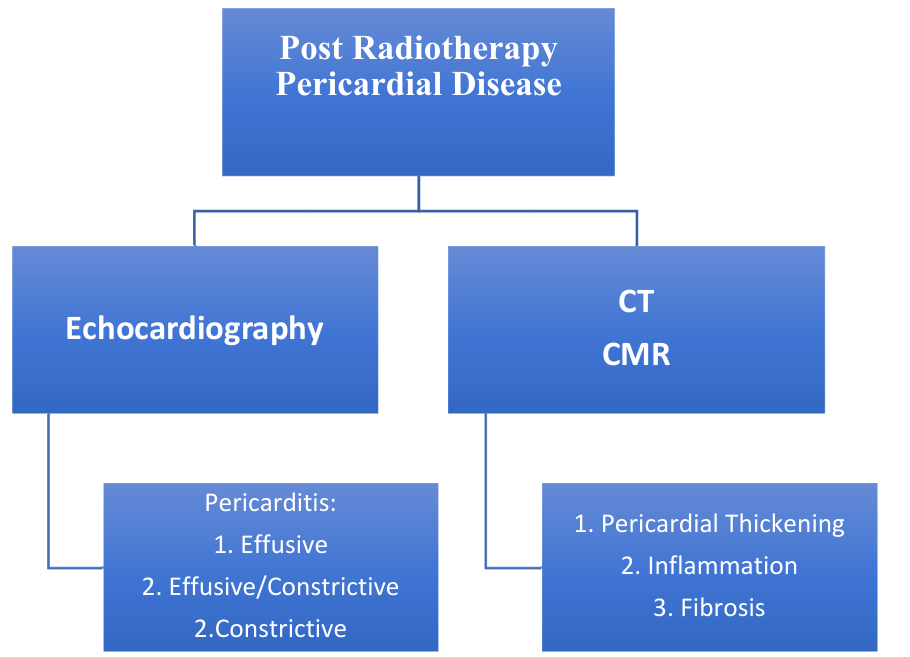
Figure 1. Evaluation of pericardial disease in patients who underwent radiotherapy. Abbreviations: CT: computed tomography; CMR: cardiac magnetic resonance [61,63,64].